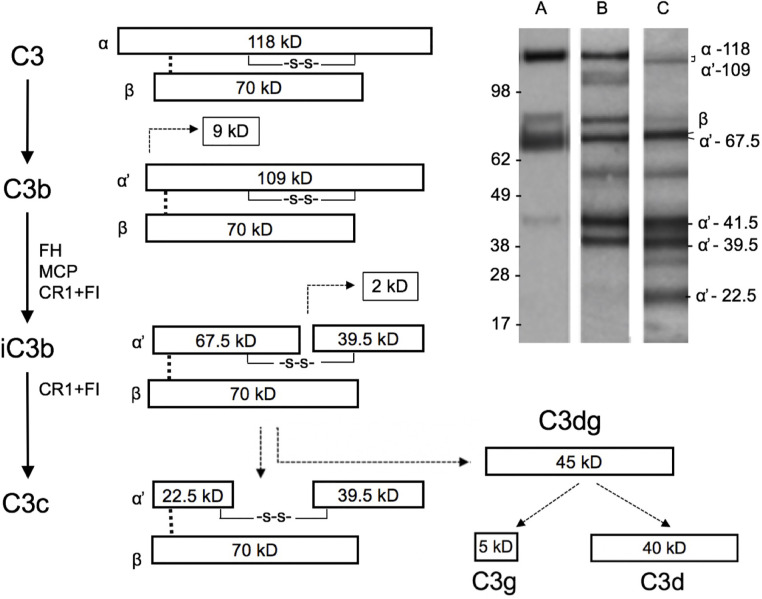
Schematic structure of C3 and its cleavage. The three distinct complement pathways will converge at C3 and promote activation of C3 to C3a and C3b by C3 convertases. The 109 kDa alpha´-chain in C3b becomes cleaved by factor I and a cofactor, e.g. factor H, to smaller 67.5 and 39.5 kDa fragments that are then part of iC3b. iC3b will subsequently get further cleaved to C3c and C3dg. The β chain remains uncleaved as a 70 kDa band. Examples of the C3 cleavage patterns (determined by rabbit anti-human C3c antibody) in our samples are shown in the upper right corner. Lanes A, B, and C show representative samples of different levels of C3 breakdown in the patient samples. Lanes A, B, and C represent samples containing C3b (A), iC3b (B), and a mixture of iC3b and C3c (C), respectively. In lane B, and faintly in lane C, the band at 118–109 kDa represents alpha/alpha-chains, which have remained uncleaved. The identity of the ≈55 kDa band is not known, but could represent a proteolytic cleavage fragment of the 67.5 kDa band. Such a fragment could be generated e.g. by plasmin, which is likely present in the mucosal fluids. The fragment above the 70 kDa beta-band could represent an autolytic cleavage product of the alpha-chain, where C3a (9kDa) has remained bound to the alpha’-67.5 kDa fragment.